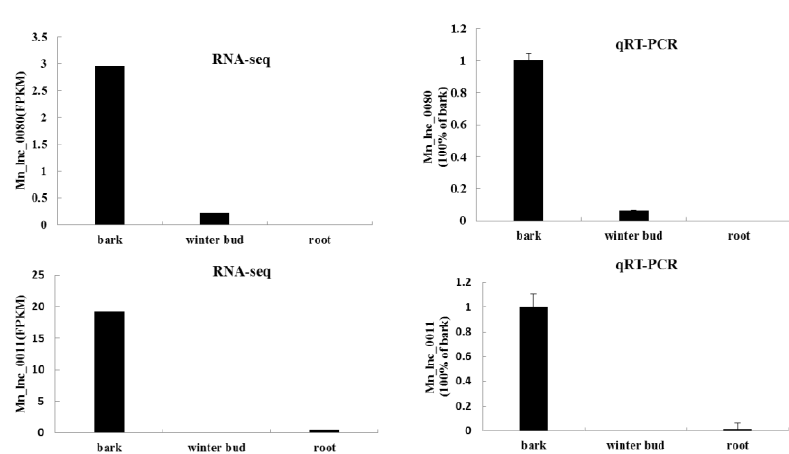
Figure 9. Typical result of qRT-PCR verification. Transcripts abundance based on RNA- seq (left) and qRT-PCR (right) is shown for lncRNAs identified form RNA- seq data.